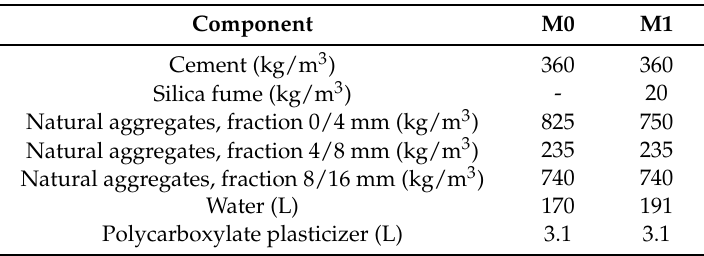
Table 5. Composition of concrete mixtures (per m 3